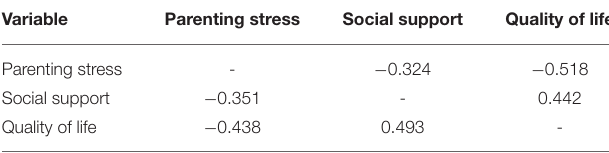
The eastern group data is at the bottom left of the correlation matrix (15 studies, 8,955 participants, harmonized N = 2,834); The western group data is at the top right of the correlation matrix (13 studies, 4,465 participants, harmonized N =